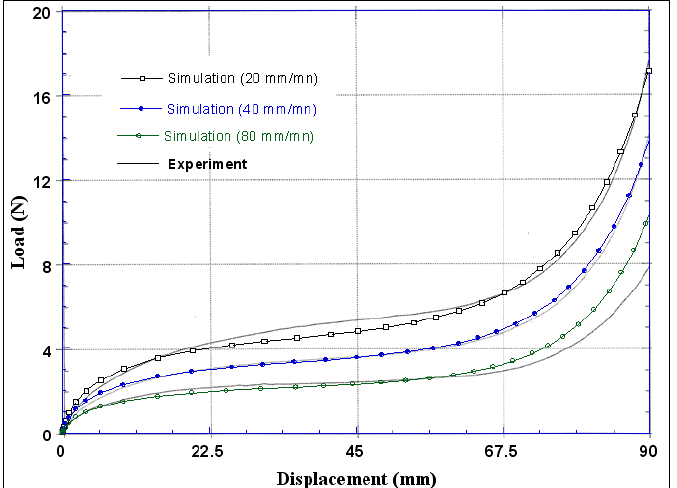
Figure 7. Effect of the load velocity of the global response for 45° of fibre orientations.